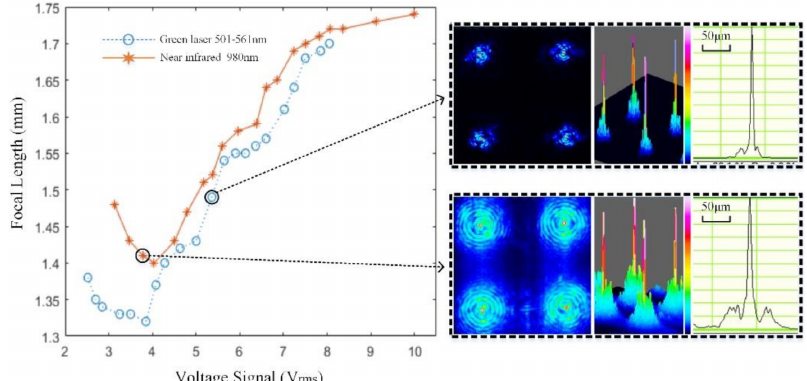
Figure 7. Relationship between the focal length of the proposed EC-LCMLA and root mean square (RMS) value of applied voltage signals. Figures in the dotted box indicate the 2D and 3D point spread functions